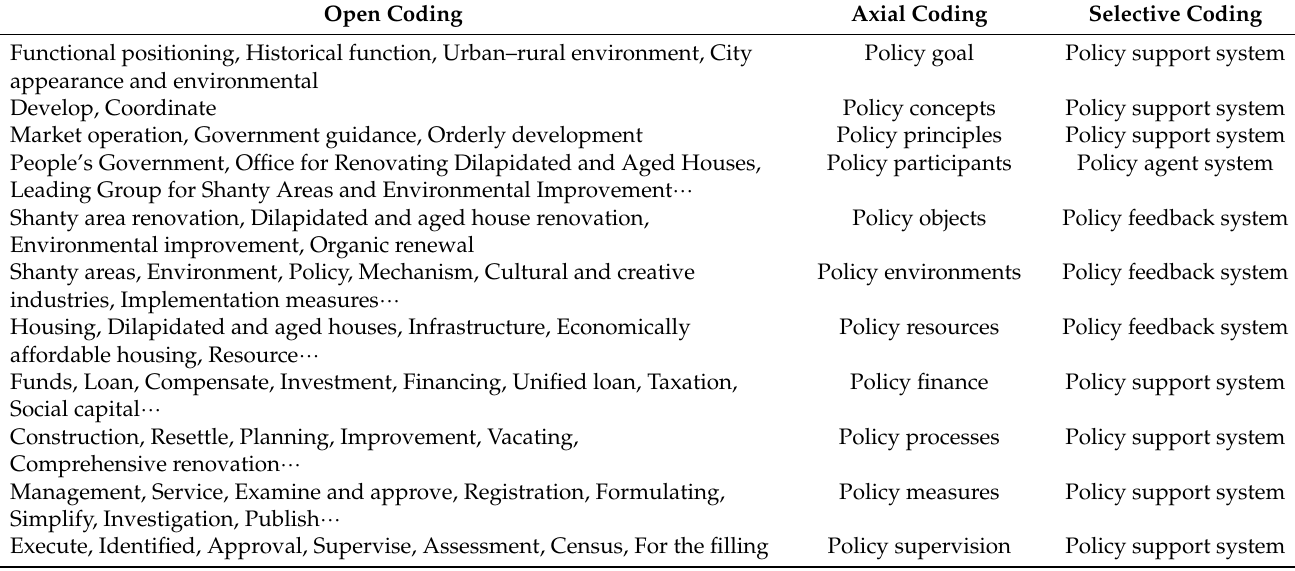
Table 4. Axial coding and selective coding table (Beijing).